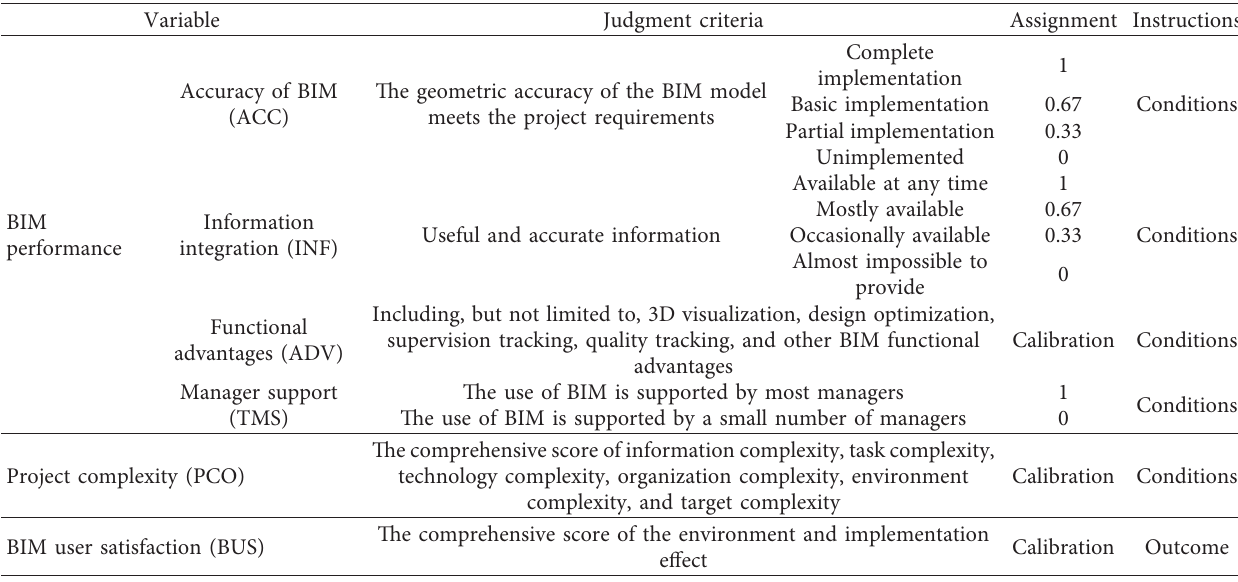
Table 2: Criteria and assignment of conditional and outcome